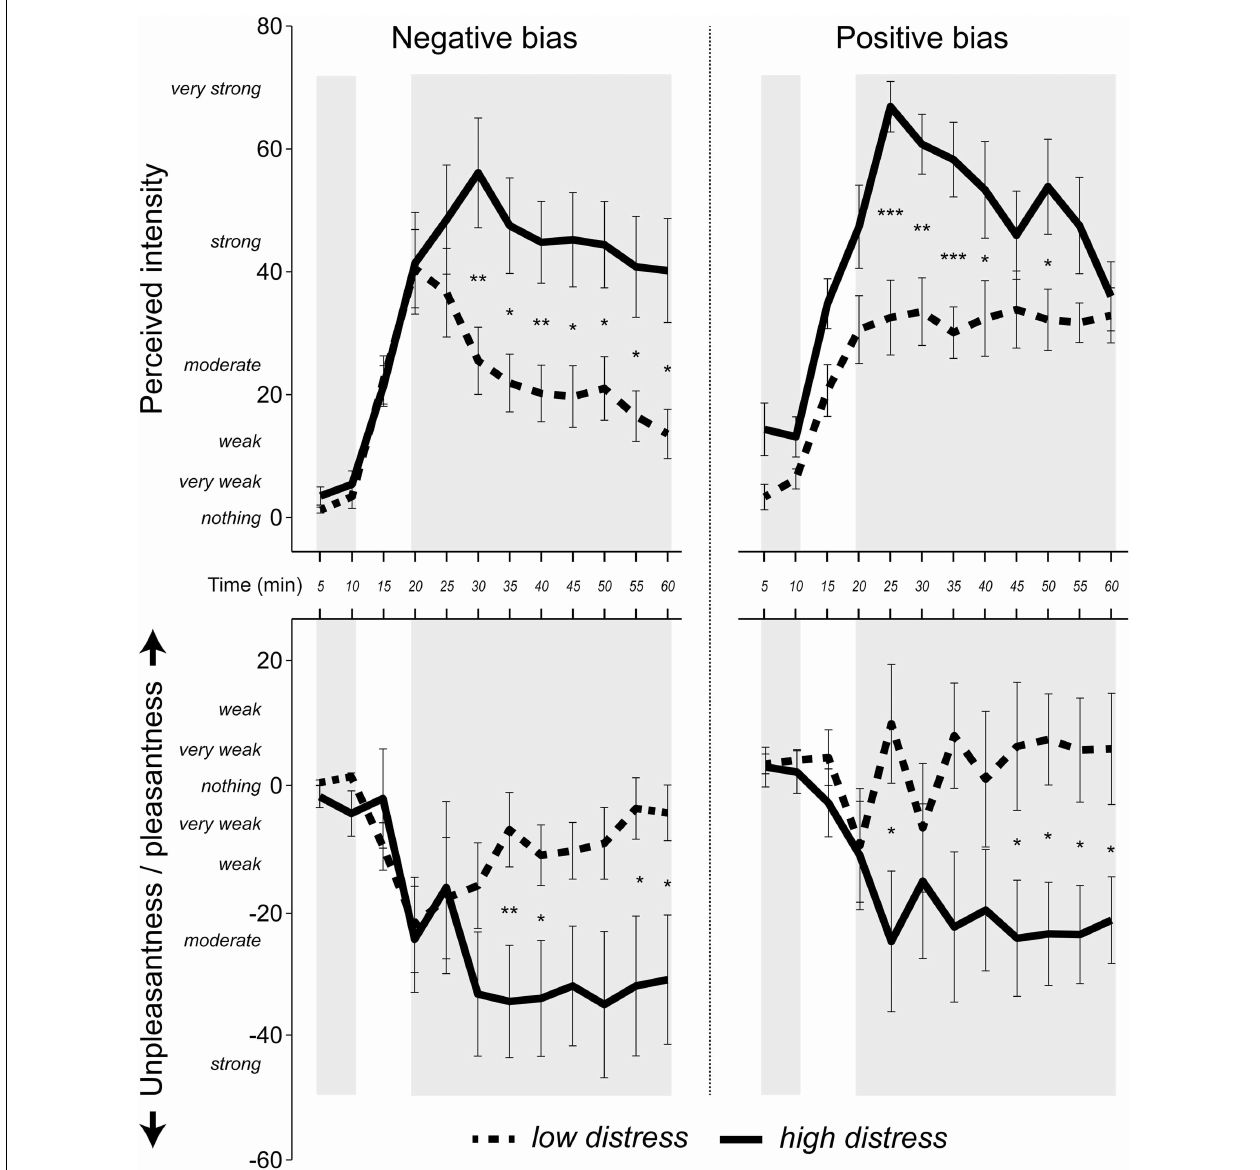
FIGURE 3 | Mean ( ± standard error) ratings of intensity and valence in 5min intervals, using a Borg CR-100 scale. Pleasantness was rated as positive values and unpleasantness as negative values. Shaded areas indicate values used in the statistical analyses. The first two